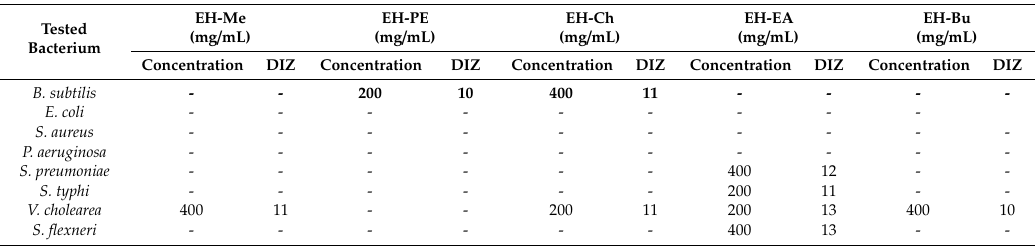
Table 3. Antibacterial activity of E. hirta Linn extracts by disc di ff usion method. - No inhibition zone observed.